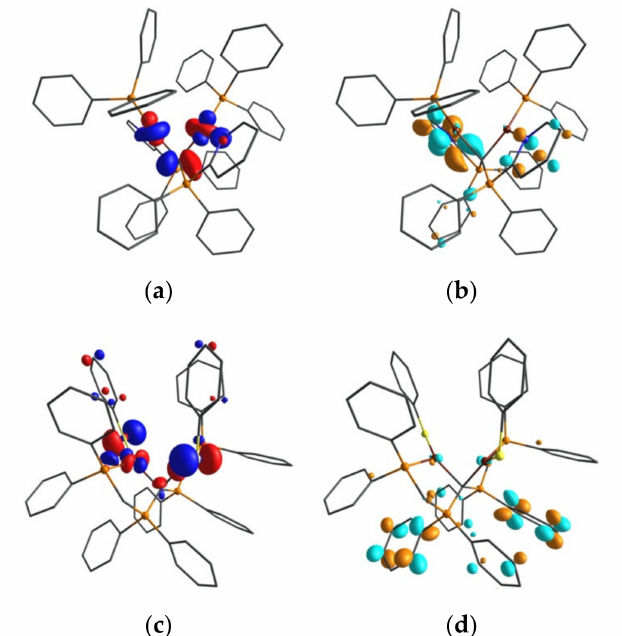
Figure 4. Kohn–Sham orbitals of HOMO (a), LUMO (b) of [(CuPPh 3 ) 2 (CDP(Py) 2 )](PF 6 ) 2 ( 4 ) and HOMO (c), LUMO (d) of [(CuSPh) 2 (CDP(CH 2 PPh 2 ) 2 ] ( 16 ) calculated for the optimized S 0 state geometry (isovalue = 0.05). Calculations were performed at the PBE-D3(BJ) / def2-TZVPP level of theory. For more details of the MOs, compare Figure S-43 and Figure S-44 in the Supplementary